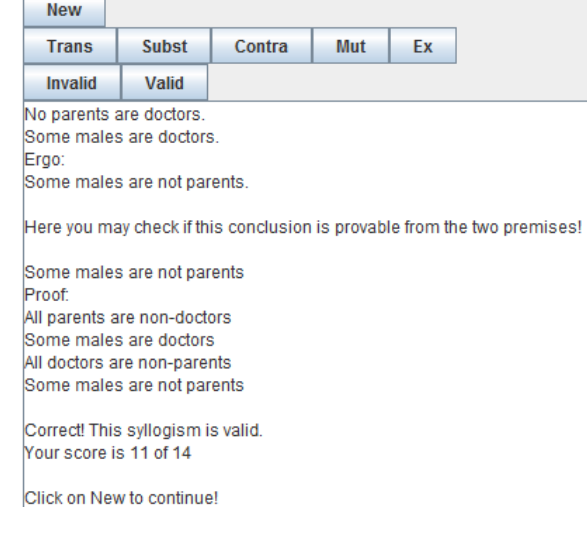
Fig.6. The interface of the Syllog system used in